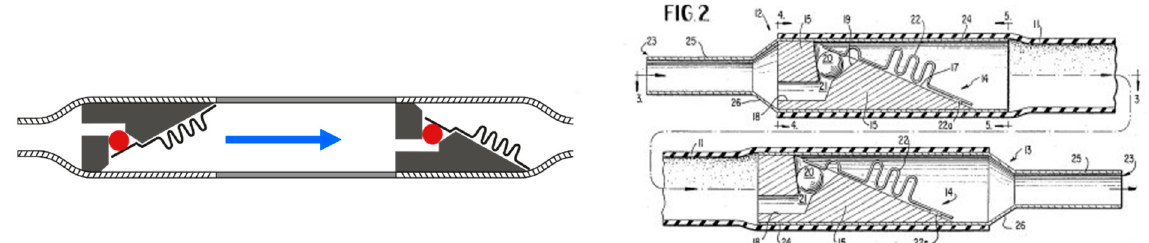
Figure 7. ( Left ): Schematic drawing of a spring-loaded ball-in-cone mechanical valve. Arrow shows the direction of the flow. ( Right ): Figure 2 of the patent filed by S. Hakim [25] with a detailed drawing of the valve that the patent describes as “a pair of spring operated ball-type check valves made of metal or other relatively inert and non-toxic material not affected by temperatures in the surgical sterilization range. The twin valves are arranged in series to face in the same direction (outlet of one adjacent to the inlet of the other)” [25].